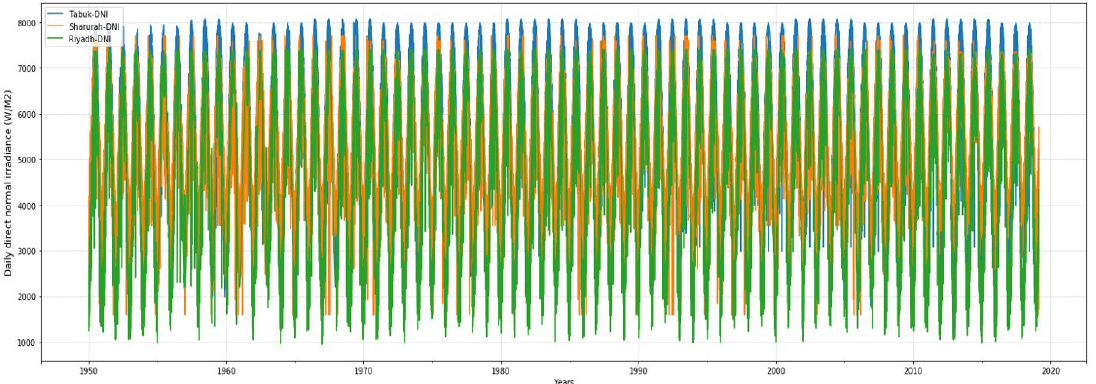
Figure 2. The direct normal irradiance performance of the three regions.